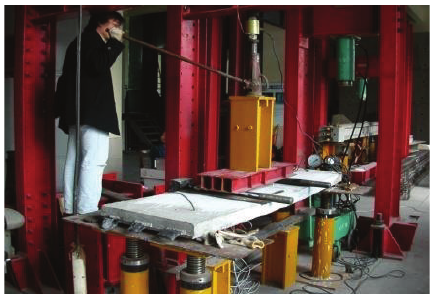
Figure 10: Photograph of the loading process.